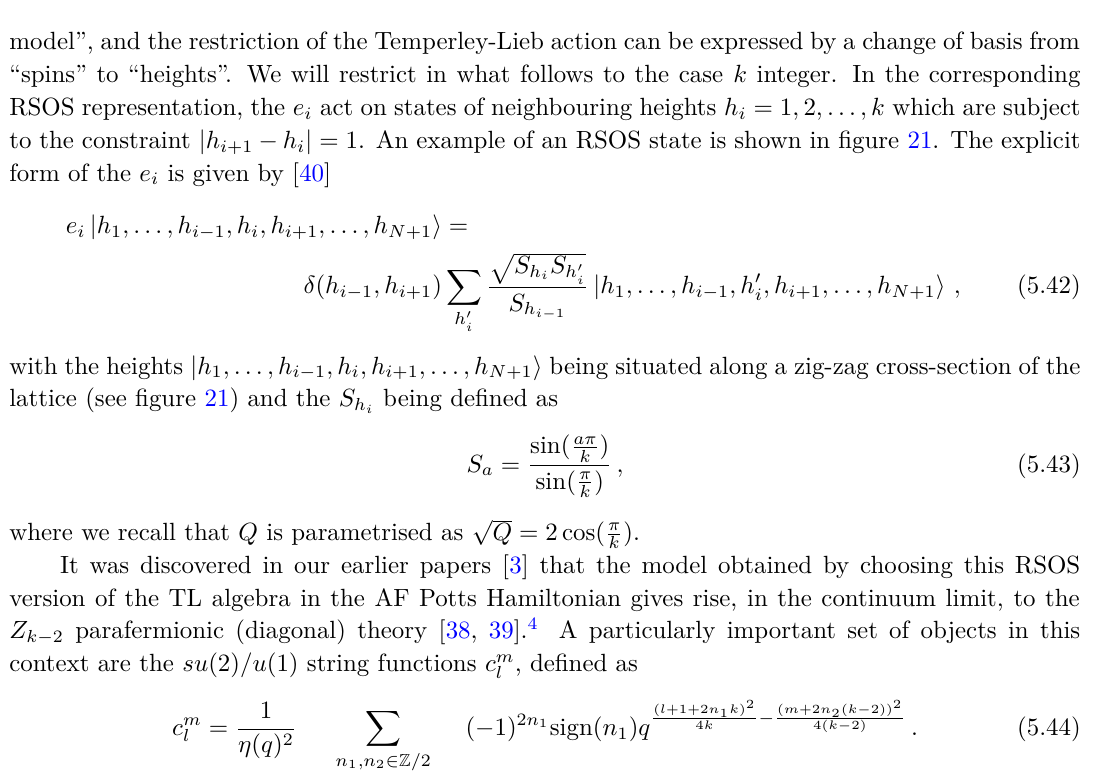
Figure 21 . The state | h 1 h 2 h 3 h 4 h 5 h 6 h 7 i